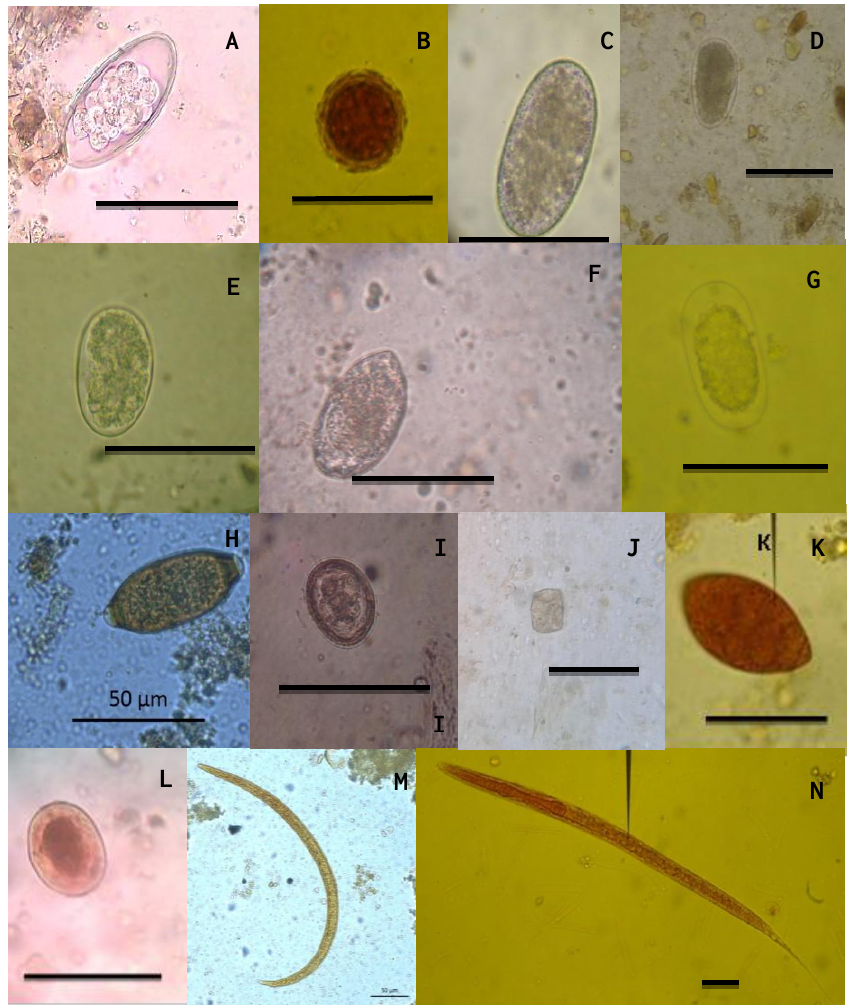
Figure 1: Helminth eggs and larvae in the faecal samples analysed from mammals in Dehiwela Zoo (A) Egg of Nematodirus sp. (B) Egg of Toxocara (C, D, E, F) Strongyle type eggs, (G) Egg of Strongyloides sp. (H) Egg of Trichuris sp. (I) Egg of Toxocara sp (J) Egg of Moniezia sp. (K) Egg of Spirometra sp. (L) Hookworm egg (M) Unidentified nematode larva in black rhino and (N) Unidentified rhabditiform larva in flying squirrel (Scale bar = 50